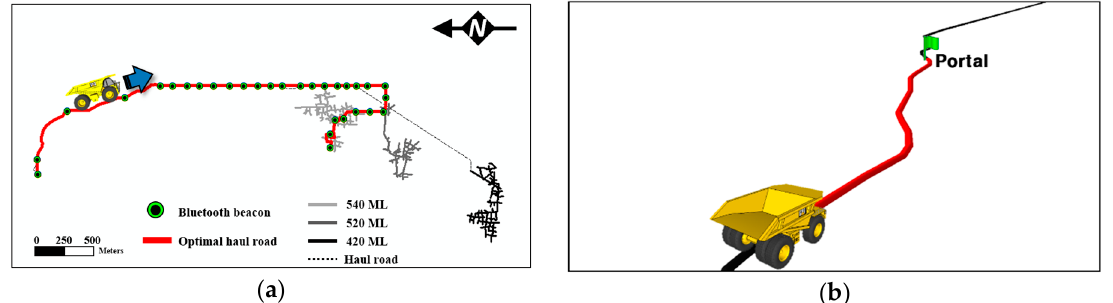
Figure 8. Screenshots of BBUNS application when the signal of a Bluetooth beacon with minor ID 3 is recognized. ( a ) Two-dimensional view of the optimal haul road showing the current location of the dump truck, the travel direction, and Bluetooth beacons installed along the path; ( b ) Three-dimensional view of the optimal haul road.